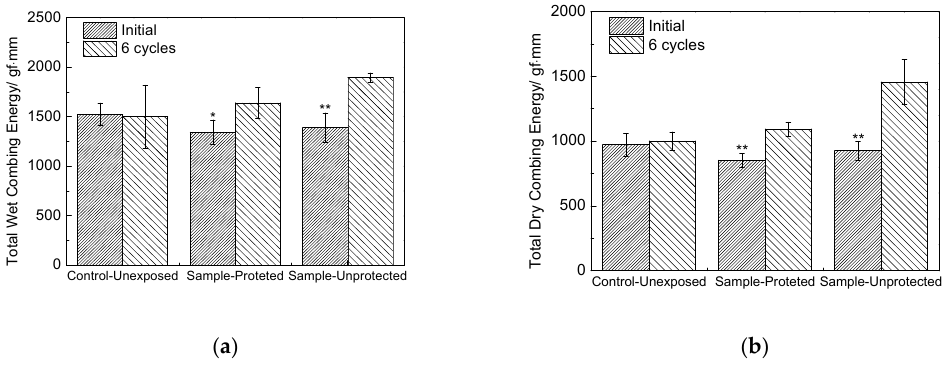
Figure 6. ( a ) Wet and ( b ) dry work combing of the protected and unprotected hair, with pre-treatment and after six cycles of smoke exposure. Note: comparison to pre-treatment, * p < 0.05, ** p < 0.01.